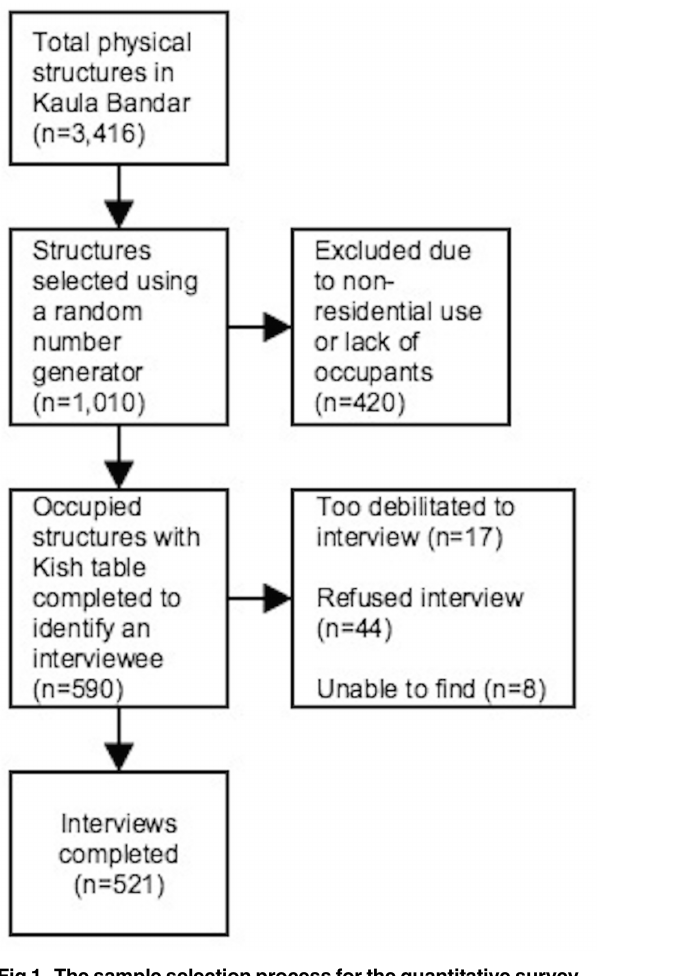
Fig 1. The sample selection process for the quantitative